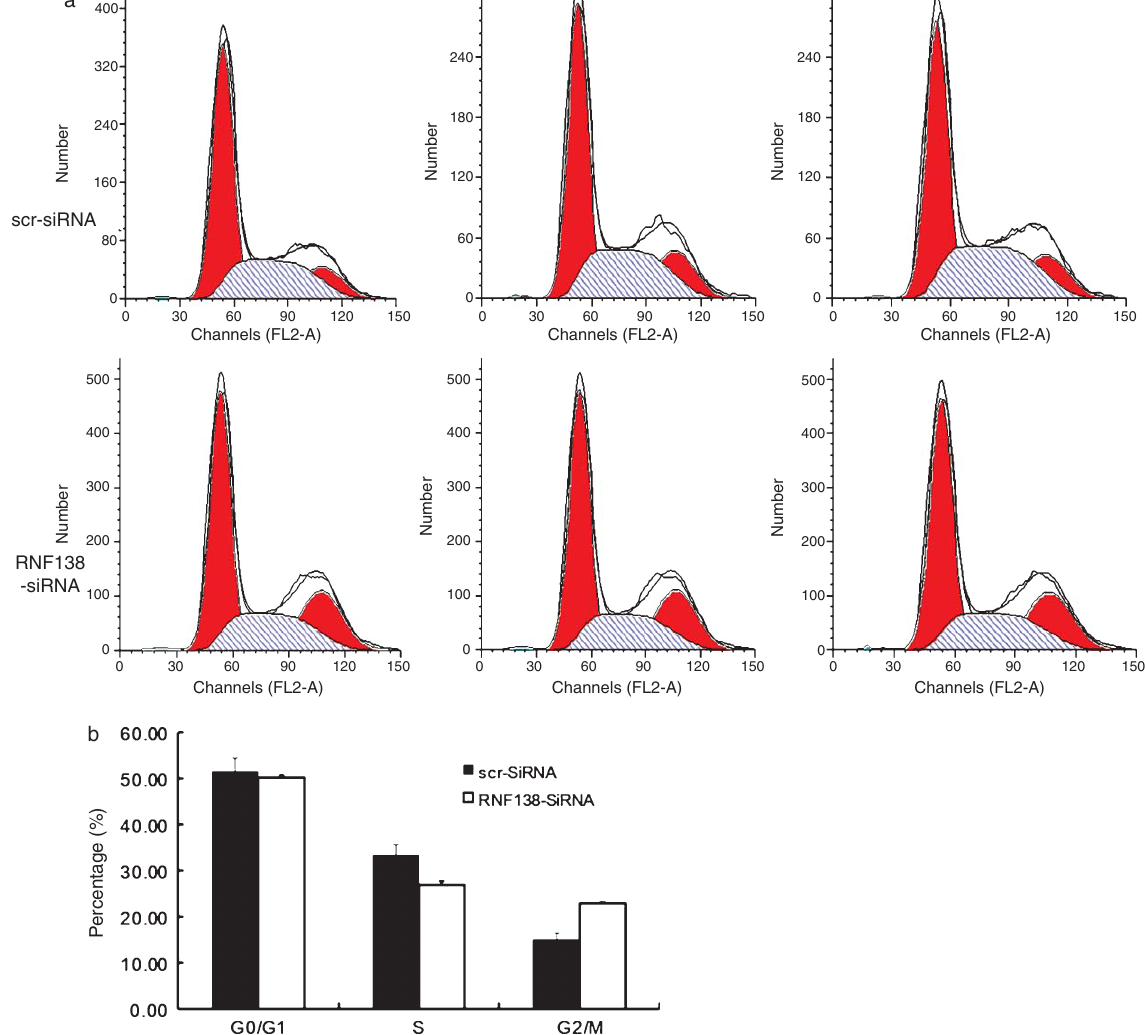
Fig.6. Effectofdown-regulationofRNF138oncellcycleofU251cells.(a)Cellcycleanalysisbyflowcytometry:Sstagecellswassignificantly decreased, while the G2/M stage cells was significantly increased when compared to the negative control cells ( P <0.05). (b) bar charts of cell cycle was drawn according to result of the FACS. The results of cell cycle examination demonstrated that the number of cells in G2/M phase was significantly increased in RNF138-siRNA targeted cell groups ( p =0.009, compared with negative control), while S stage cells was significantly decreased ( p =0.03). No change in the percentage of cells in G1 phase was seen.